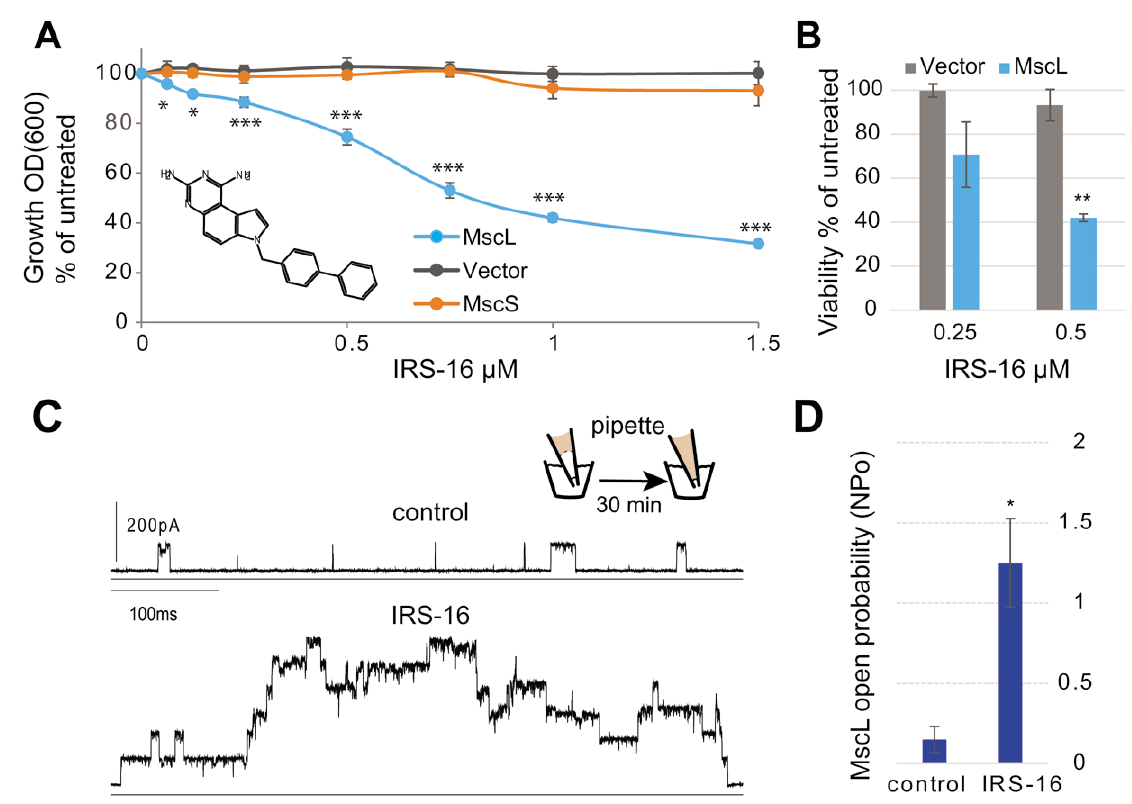
Figure 3. The antibiotic effects of IRS-16 in vivo are dependent on MscL expression. ( A ) E. coli strain MJF455 ( ∆ MscS, ∆ MscL) cultures, carrying an empty vector (gray), expressing MscS (orange), or expressing MscL (cyan) were treated with increasing concentrations of the compound IRS-16 (insert). The graph represents growth inhibition as a percentage of the non-treated cultures ( n = 4) * p < 0.02, *** p < 0.0005. ( B ) Viability of E. coli MJF455 cells, carrying an empty plasmid (gray) or expressing MscL (cyan) after treatment of IRS-16. Results are graphed as a percentage of the untreated cultures ** p < 0.003 Student t -test MscL vs. vector. ( C ) Representative traces of the MscL activity recorded by a patch clamp on native bacterial membranes. Experiments were performed using the back-filled pipette configuration (scheme), where channel activity was measured shortly after patch formation (control, upper trace ) and then again after diffusion of the compound to the pipette tip ( lower trace ). The same patch was recorded at the same pressure before and after treatment. ( D ) Quantification of the channel activity is shown as the probability of opening (Npo) of the MscL channel before and after treatment while held at the same pressure ( n = 4). * p < 0.05 t -test paired treated vs.